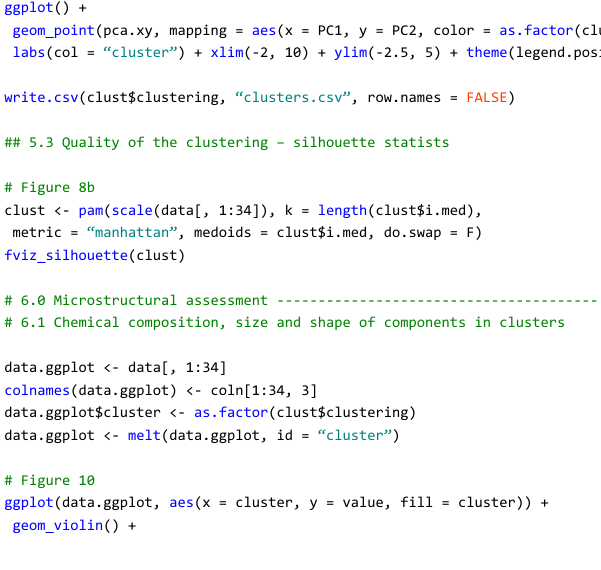
write.csv(clust$clustering, “clusters.csv”, row.names = FALSE)